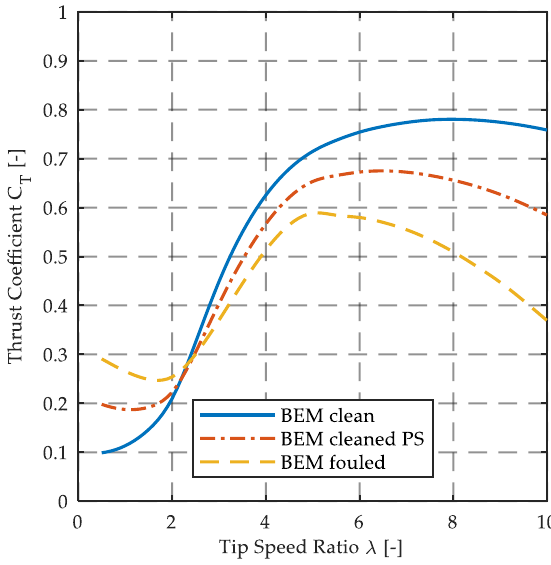
Fig. 12 Thrust coefficient as function of the tip speed ratio (BEM prediction of the different blade conditions)